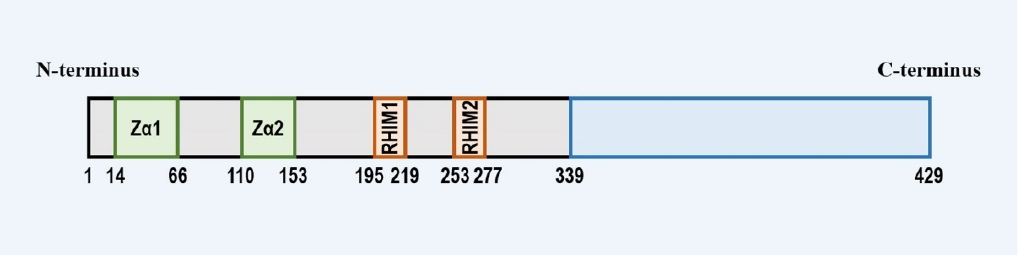
Figure 1. Illustration of the domain structure of ZBP1. ZBP1 consists of two N-terminal Z-form nucleic acid binding domains, two RHIM domains of the intermediate segment, and the C-terminal